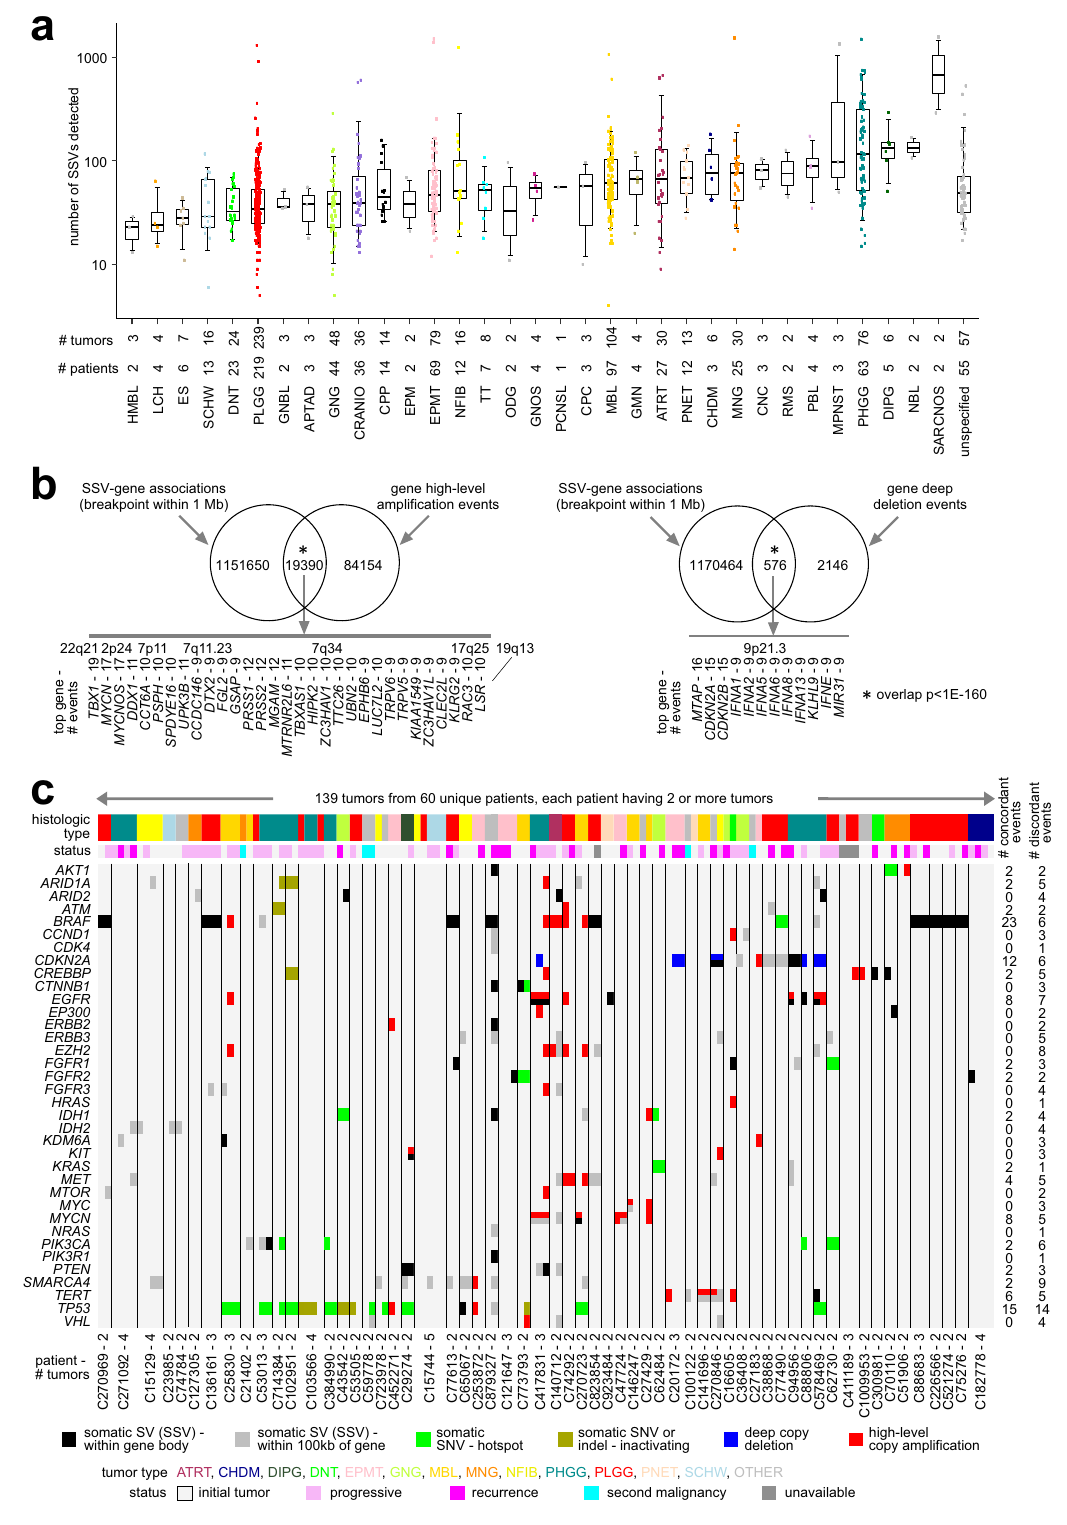
within gene body